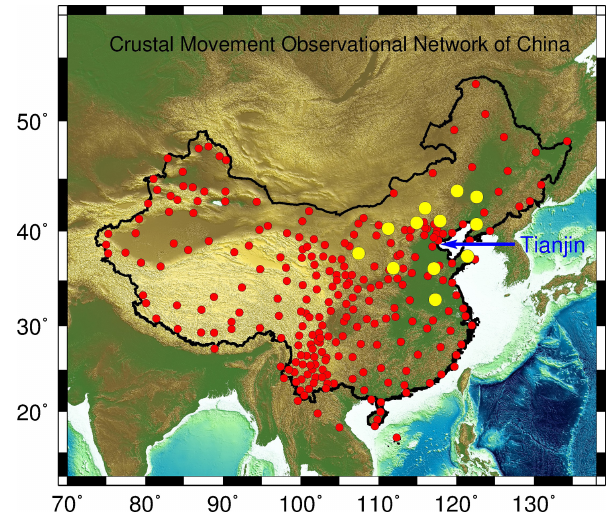
Figure 1. Map showing the locations of 260 permanent GPS sta- tions (red) of the Crustal Movement Observational Network of China (CMONOC) and 12 reference stations (yellow) utilized to realize the stable North China Reference Frame 2016 (NChina16, Wang et al.,